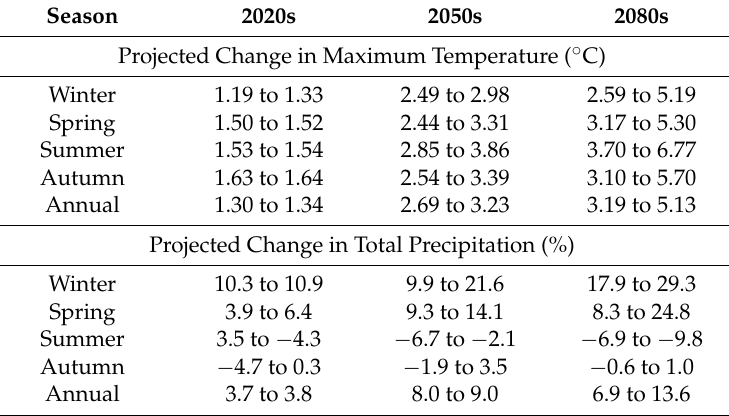
Table 2. Selective Ensemble of Seasonal GCM Output for Maximum Temperature and Total Precipitation at Toronto Lester B. Pearson International Airport from 2011 to 2100 under RCP4.5 and RCP8.5 Climate Change